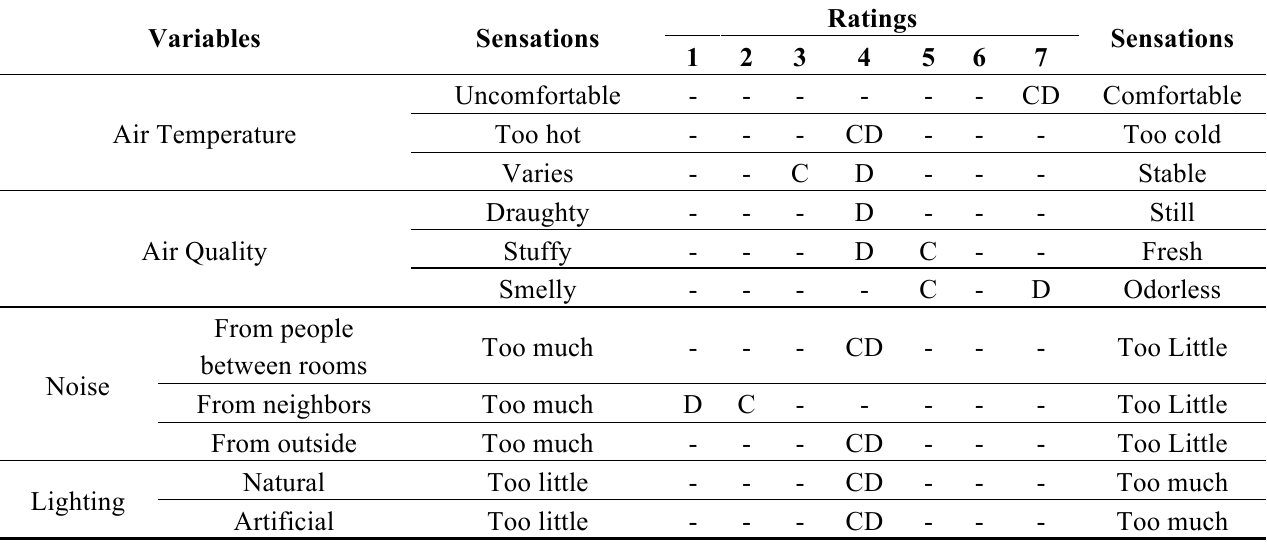
Table 3. Building Use Studies (BUS) surveys: comfort analysis.